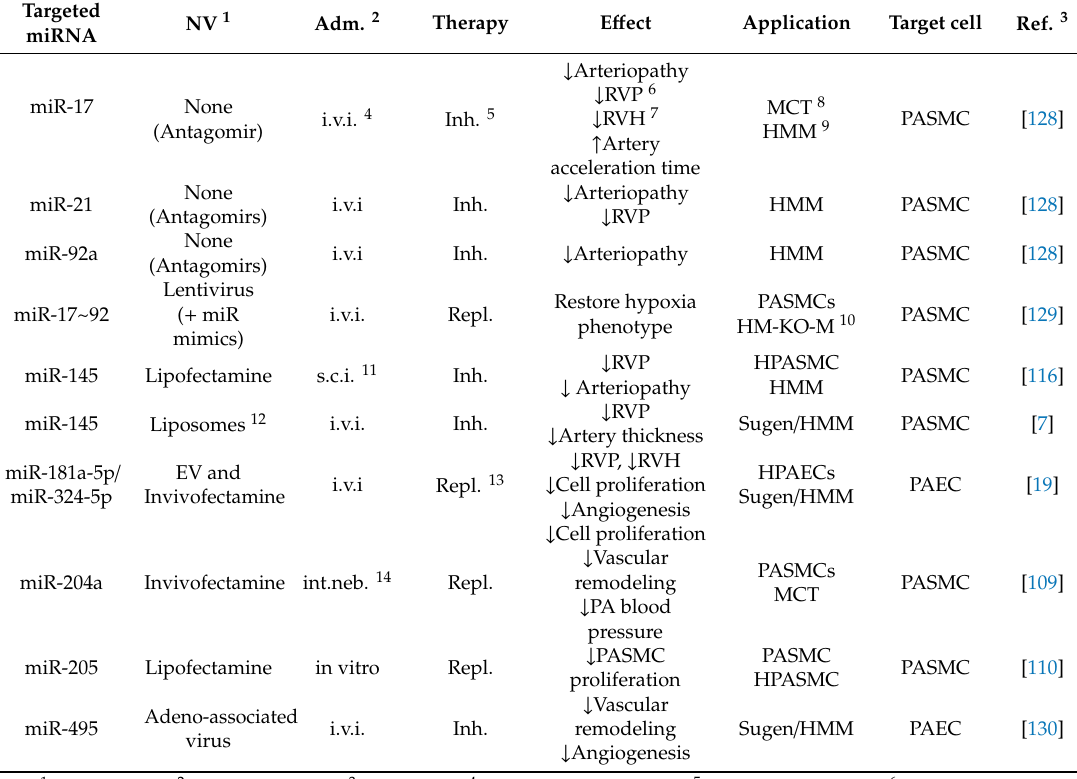
Table 3. Relevant information about miRNA-based therapies in pulmonary